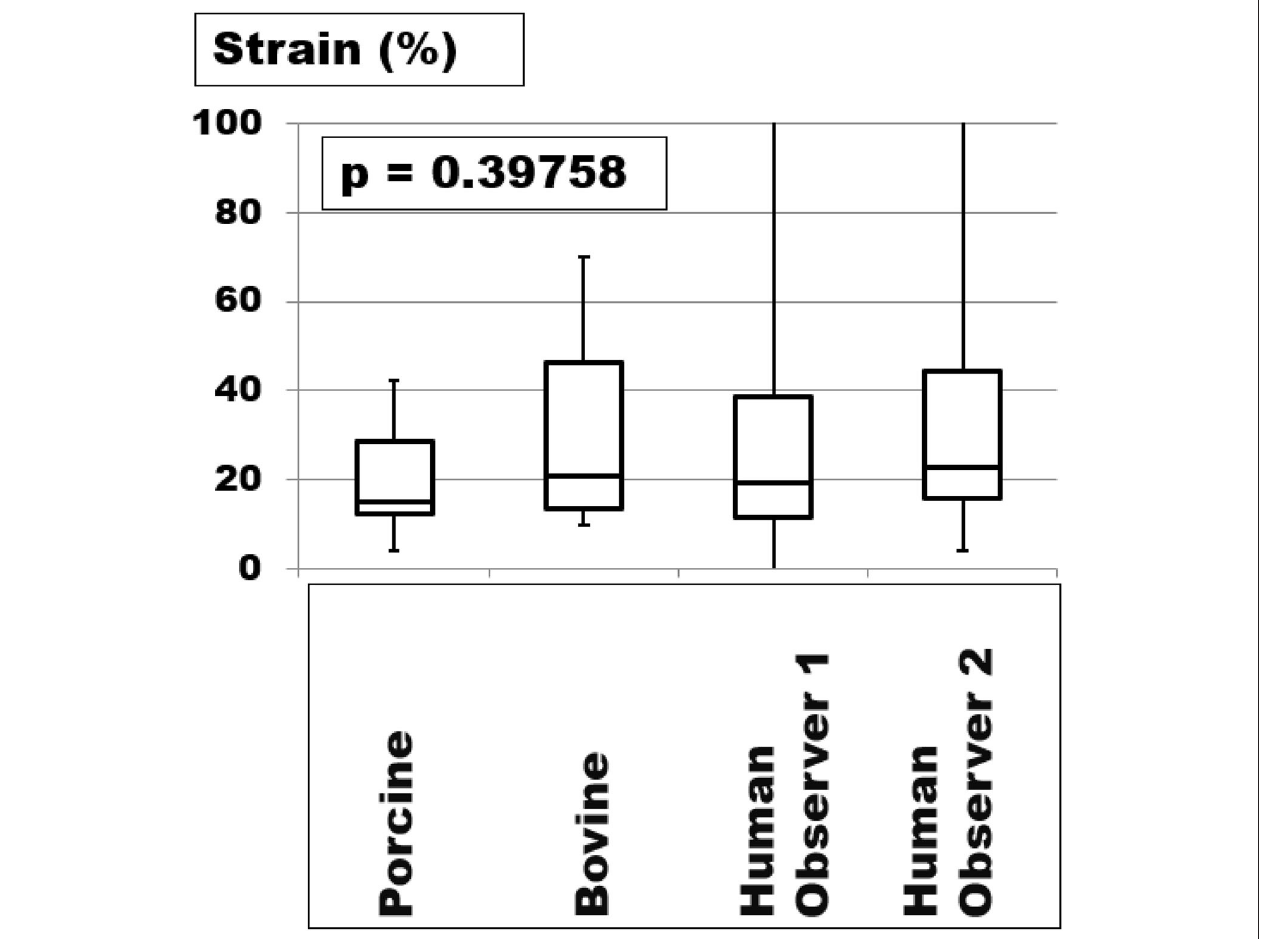
FIGURE 3 | The strain was measured in porcine and bovine samples with the Tissue Analyser® and human tissue with computerized tomography of the abdomen at rest and during Valsalva’s maneuver. The box- and whisker plots are the results of at least fifteen up to forty observations. The human tissues vary more with the whiskers up to the maxima being truncated at 100% for the sake of the clarity of the